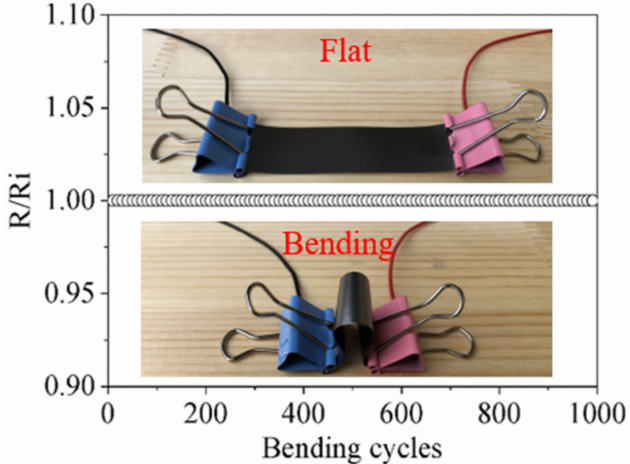
Figure 4. Mechanical flexibility test of the HCGAF